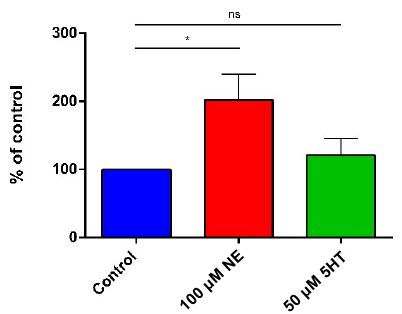
Figure 2. E. faecium NCIMB10415 adhesion on Caco-2/TC7 cells in control condition (blue) or stimulated with 100 µ M NE (red) or 50 µ M 5HT (green). Treatment with 100 µ M NE increases the bacterial adhesion. The results are represented as % of control ± SEM. * p < 0.05; ns: not significant.